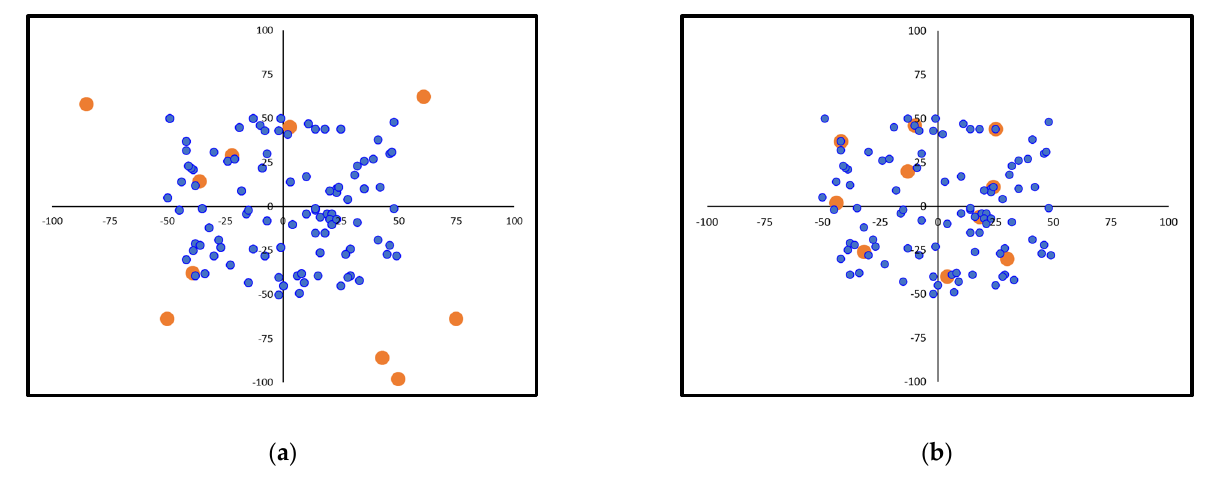
Figure 10. Indicative charging station deployment example for a − 100 to 100 field range: ( a ) initial random solution; ( b ) final optimal solution (demand points in blue color, charging stations in orange color). Table 2. Optimization distance results for Case Study 6.